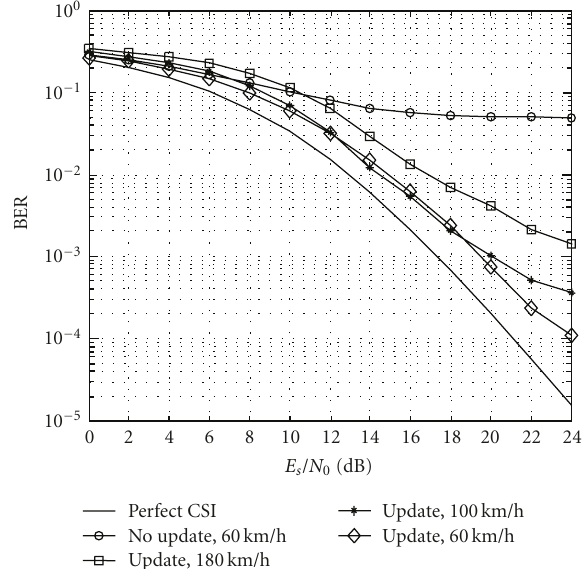
Figure 7: QPSK BER with and without channel